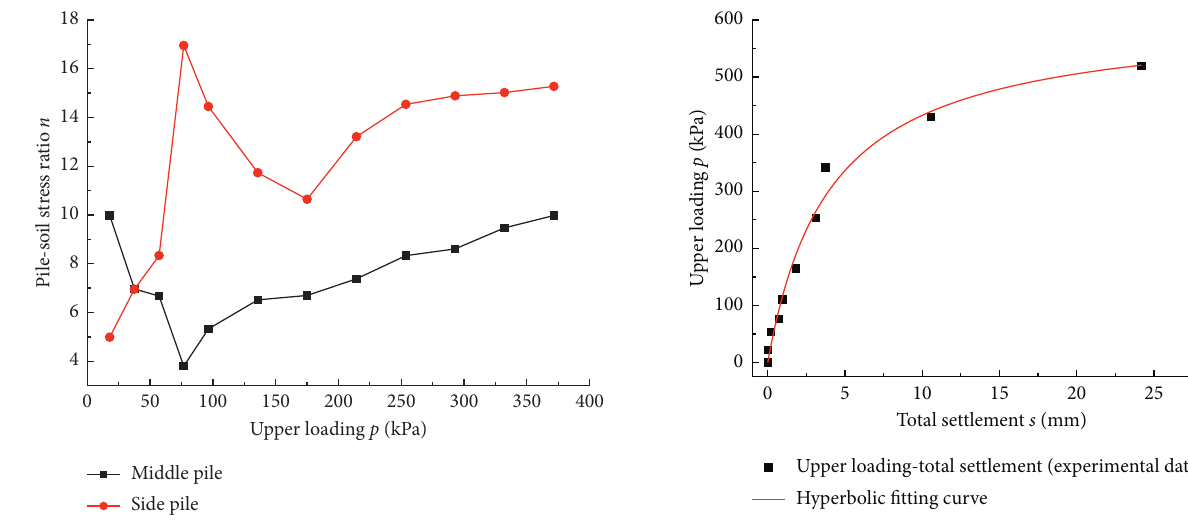
Figure 10: Variation of the pile-soil stress ratio with the growth of upper load in the group pile composite foundation.